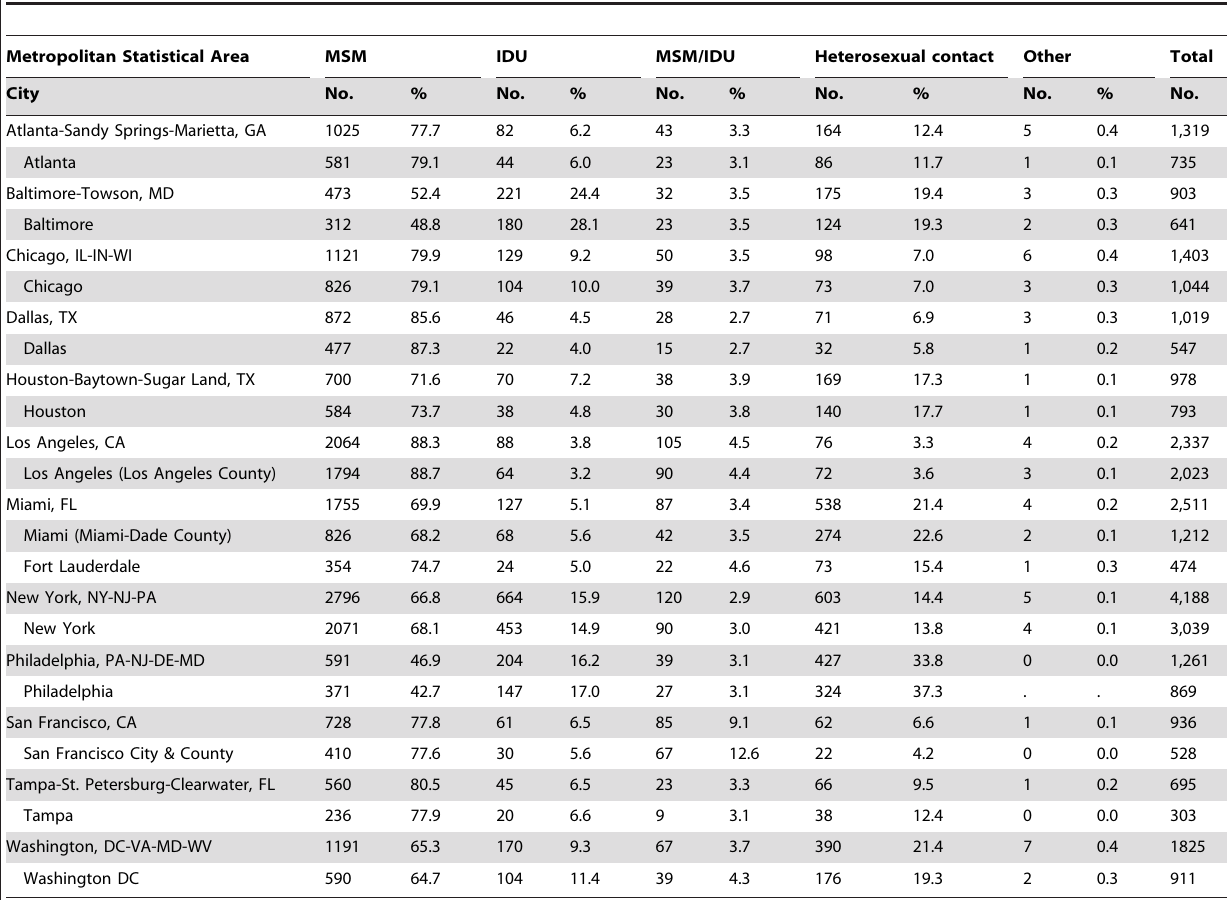
Table 4. Numbers and percentages of adult and adolescent males diagnosed with HIV infection, by transmission category and area of residence, United States,